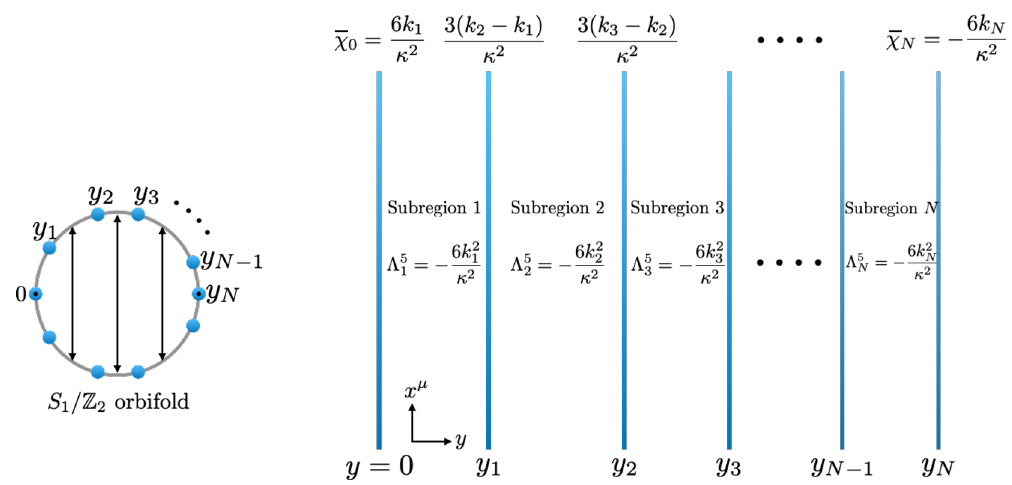
Figure 2 . Schematic pictures of the N + 1 3-brane system. The left panel denotes the S 1 / Z 2 orbifold extra dimension where + y and − y are identified and y = 0 , y N are the fixed points. The N + 1 3-branes are located at y = 0 , y 1 , y 2 , · · · , y N − 1 , y N . In the right panel, Λ 5 cosmological constant in the subregion p defined in y p − 1 < y < y p . The brane tension ¯ χ p for the brane at y = y p is obtained by ignoring the effect of the GW field on the brane-localized